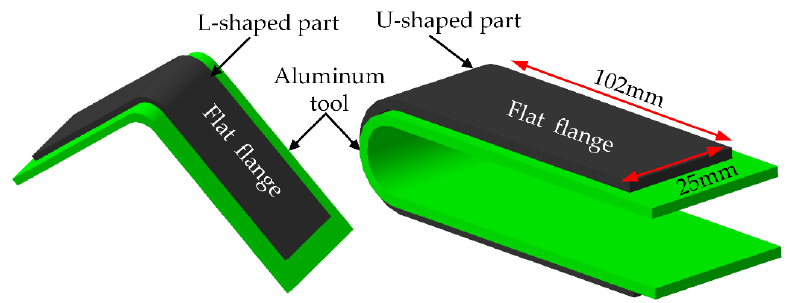
Figure 2. Geometry and shape of the specimens.